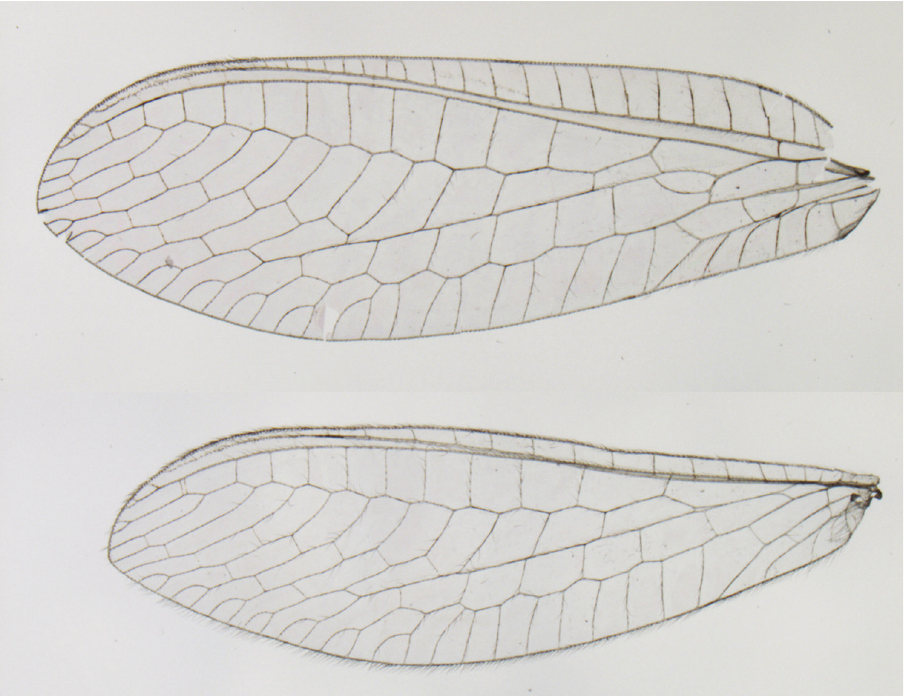
Figure 72. Ungla species near pallescens Penny: Wings (Bolivia, Cochabamba, female, FSCA). Ungla pennyi Tauber , sp.